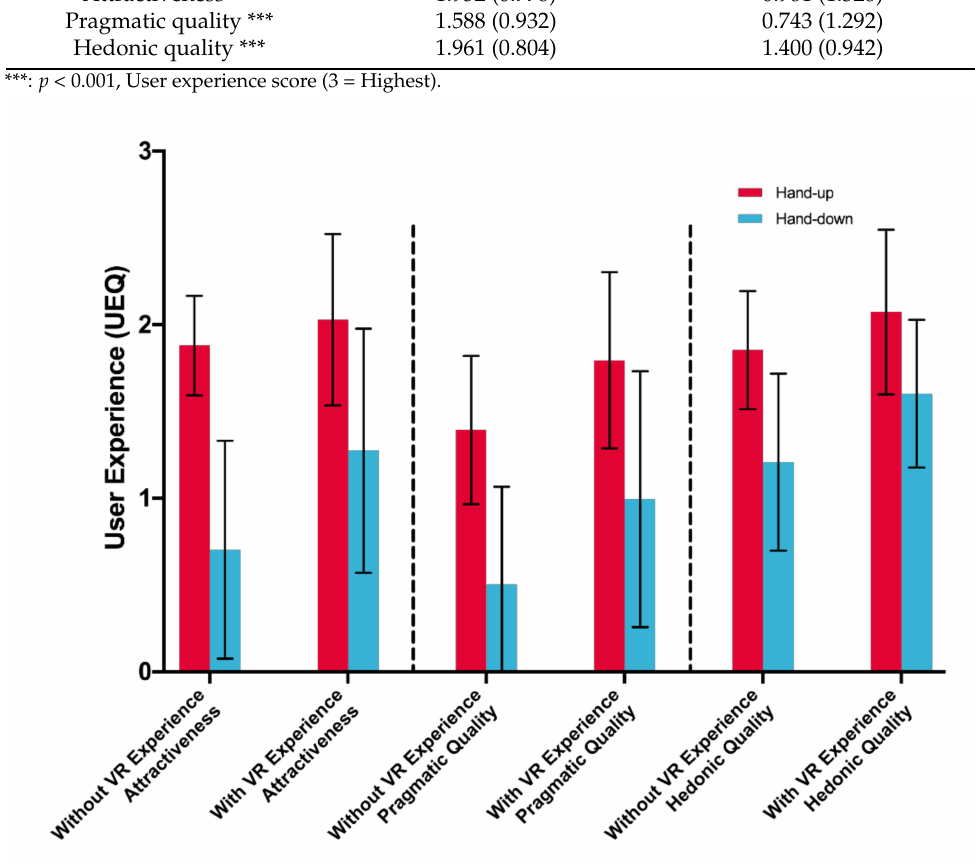
Figure 8. User Experience (3 = Highest). Error bars represent 95%